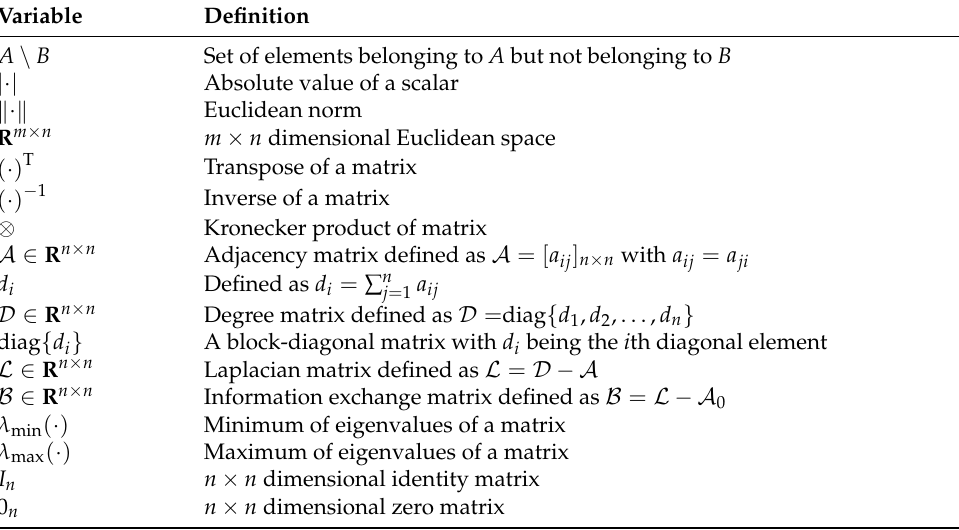
Table 1. Notations and variables used in this